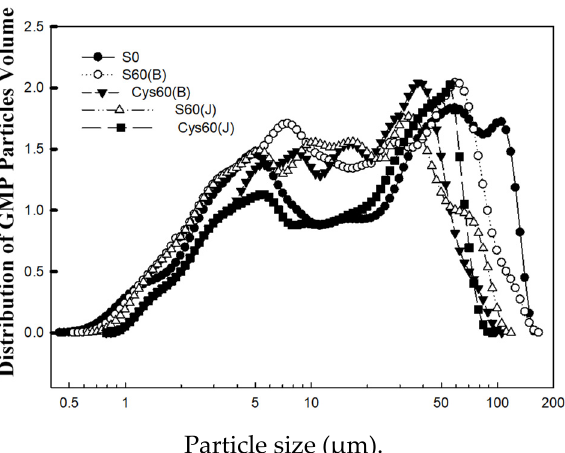
Figure 4. Effects of cysteine and inorganic sulfur at different stages on GMP particles volume in flour. Different small letters in the same column of each treatment are significantly different at a 0.05 probability level. Table 2. Effects of cysteine and inorganic sulfur application at different stages on distribution of GMP particles volume.